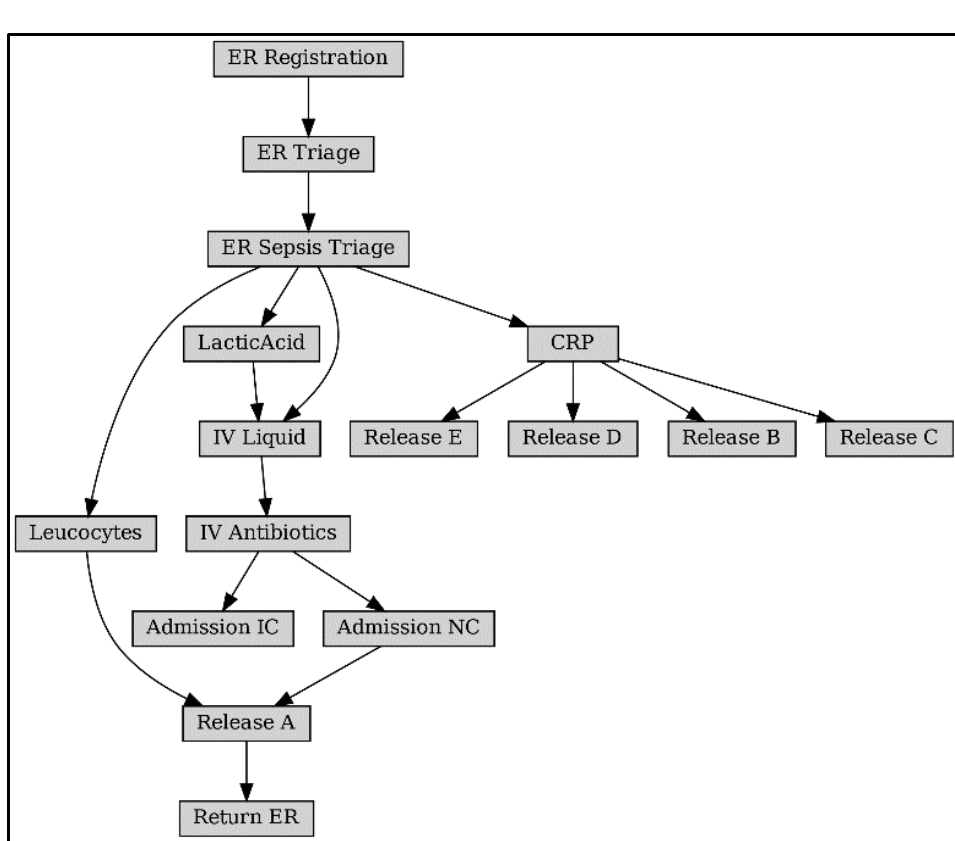
Figure 10. Process-based Bayesian Network for Sepsis.